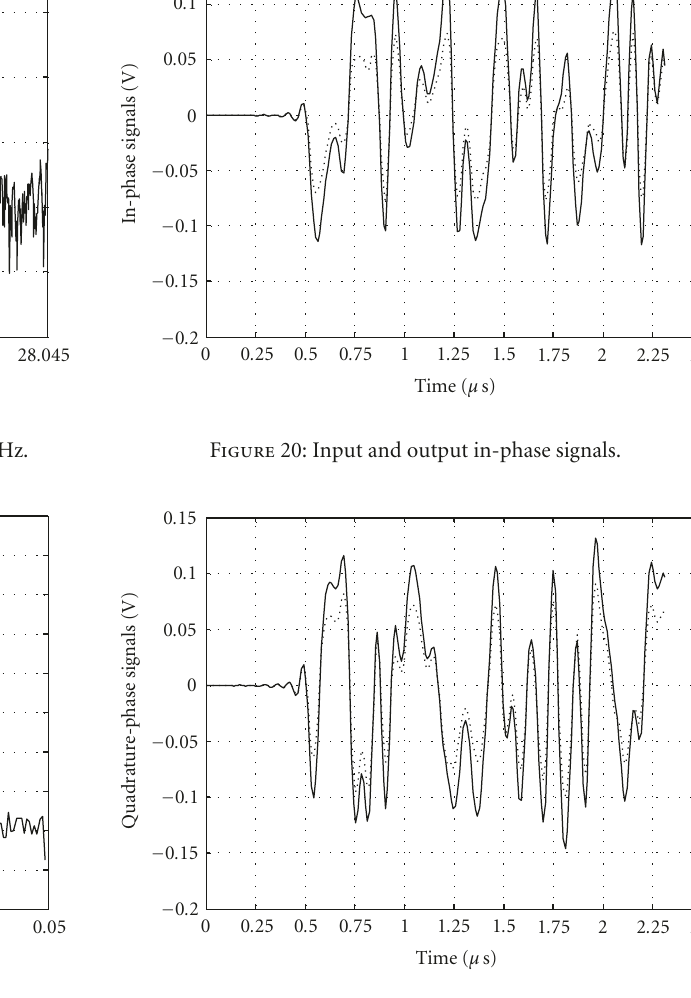
Figure 21: Input and output quadrature-phase signals.